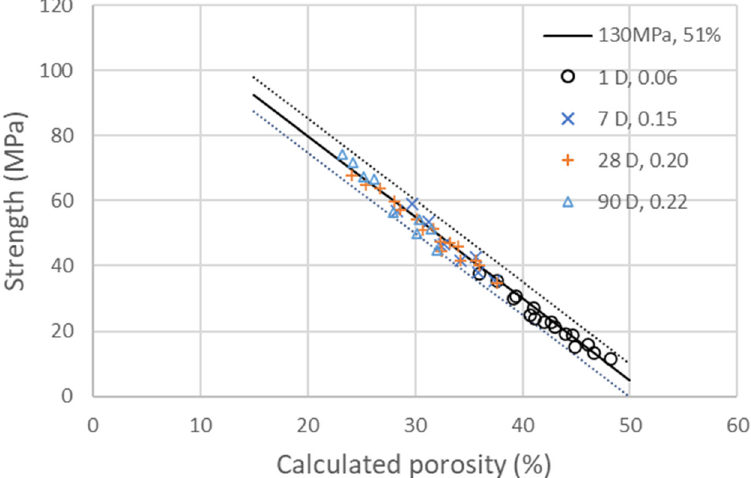
Figure 3. Compressive strengths of the four different additions of GCC presented in Table 6 at 1, 7, 28 and 90 days as a function of the calculated porosity. The line corresponds to the linear evolution of compressive strength with porosity, as explained in Equation (3), with σ 0 = 130 MPa, φ mC = 51%. The dotted lines on the side represent a deviation of σ 0 and φ mC of ±